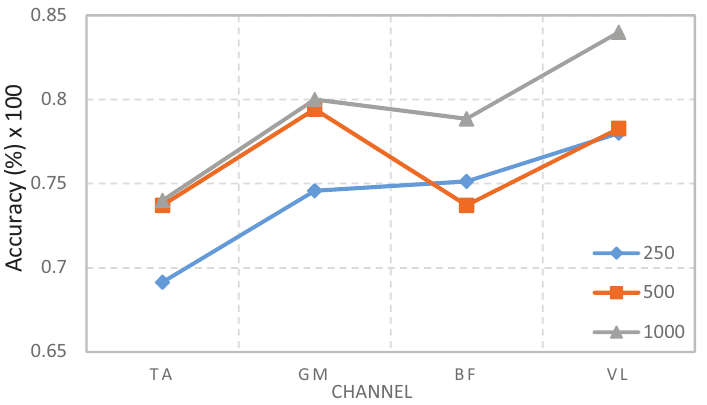
Figure 2. Classification accuracy with a single